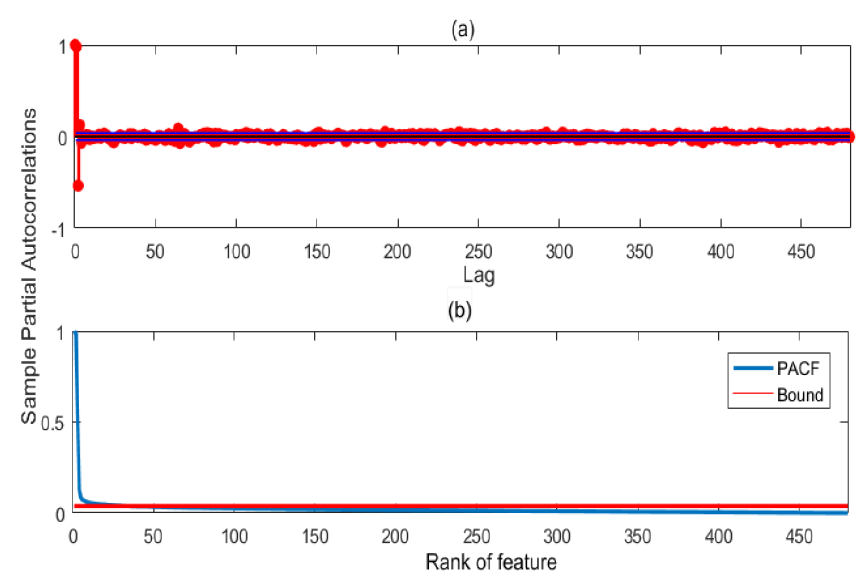
Figure 3. PACF for each time lag variable and ranked PACF in Beijing. ( a ): PACF for each time lag variable; ( b ): ranked PACF. The closer the value is to 1, the greater the partial correlation. Conversely, the closer the value is to 0, the smaller the partial correlation.